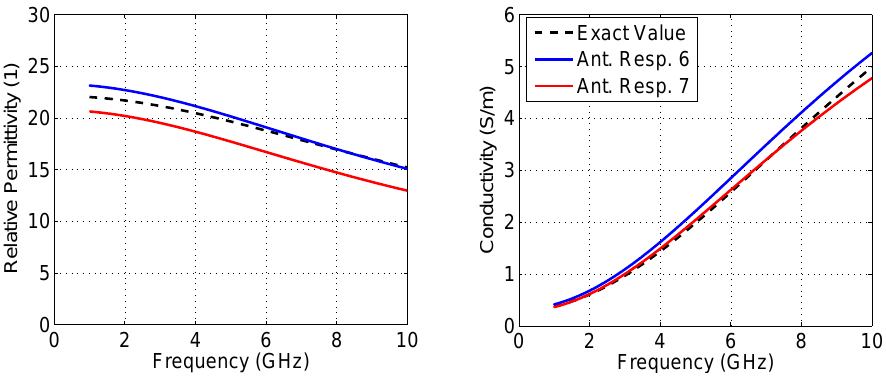
Figure 6. Average dielectric property (DP) estimate for a simulated tissue with DPs between Samples 6 and